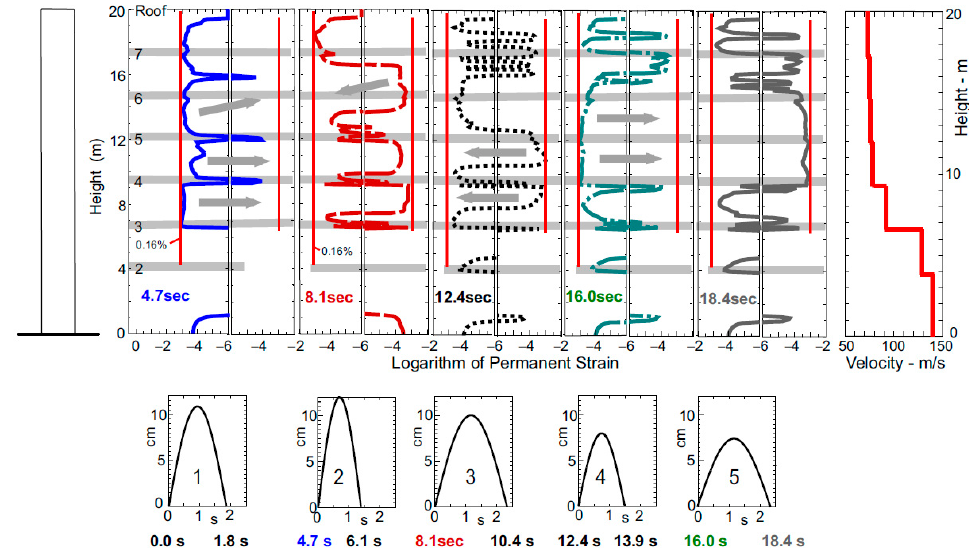
Figure 12. The permanent strains in the building model resulting from a sequence of five pulses (pulses start at 0.0 s, 4.7 s, 8.1 s, 12.4 s, and 16.0 s). Strains are shown during the quiescent ground-motion times—before the onset of the following pulses (before 4.7 s, 8.1 s, 12.4 s, and 16.0 s) and after the fifth pulse at 18.4 s. Vertical red lines labeled 0.16% show that the permanent strains did not exceed this value.